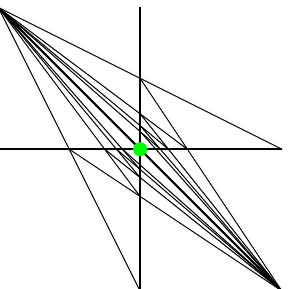
Figure 3. A schematic representation of the cone structure near the limiting ray in some 3- dimensional scattering diagram. We are looking down on the limiting ray, which corresponds to the green